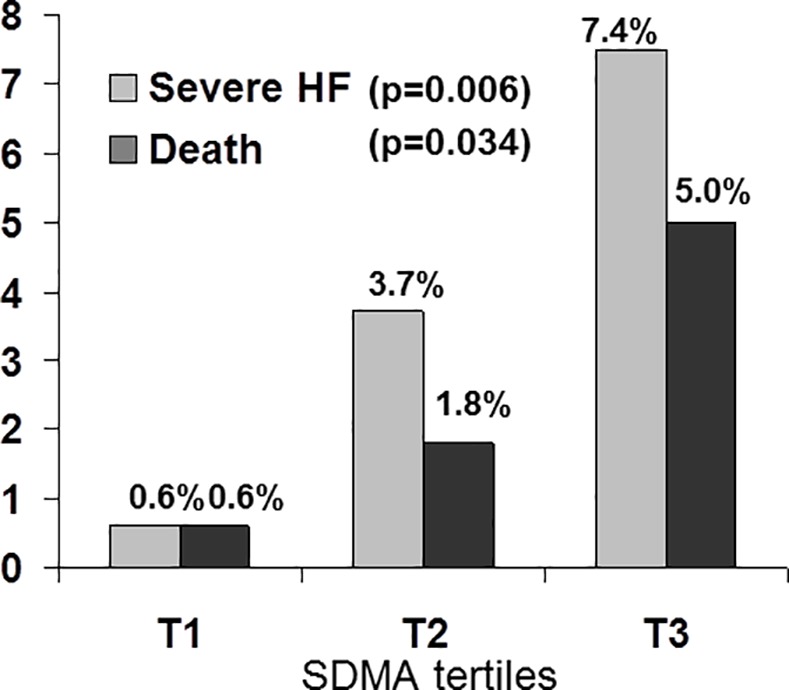
Cardiovascular outcomes according to Symmetric dimethylarginine tertiles values (p value for comparison between the tertiles).